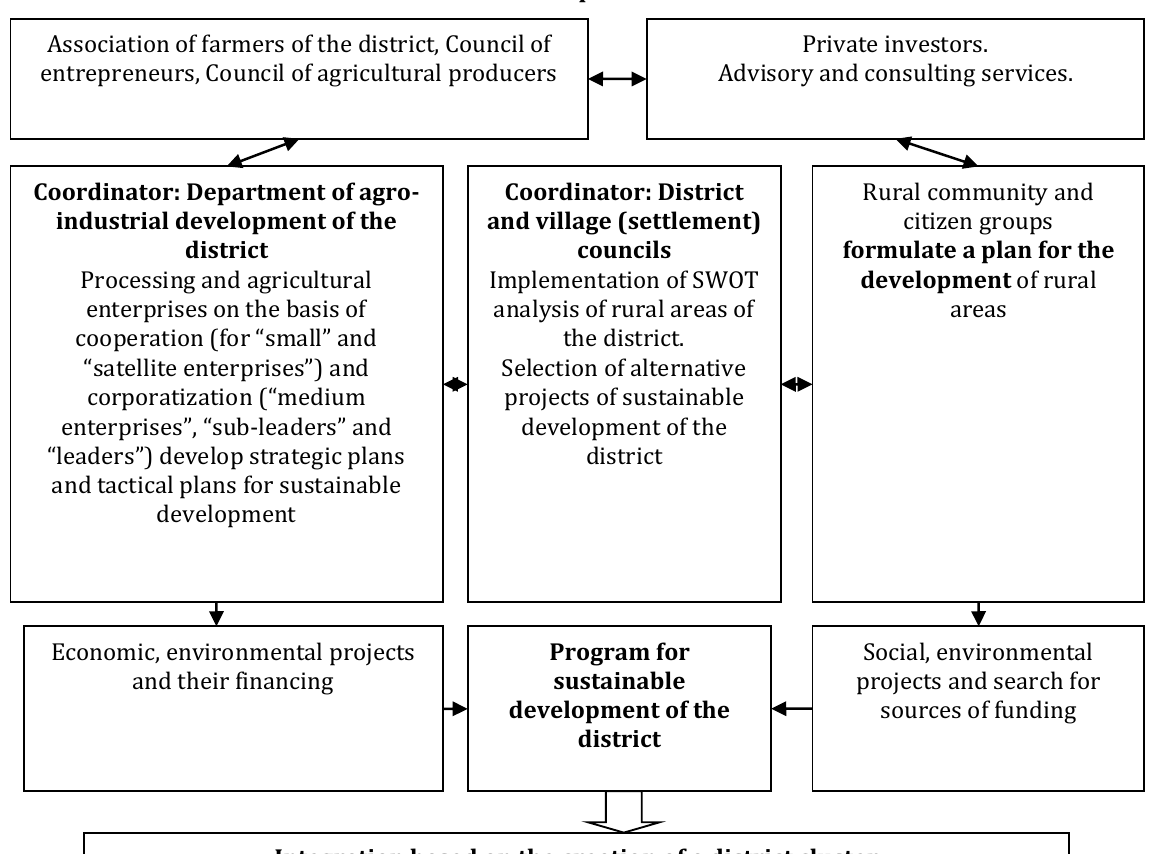
Figure 3: Model of strategic planning for the progress of cooperative and corporate structures on the basis of development of rural